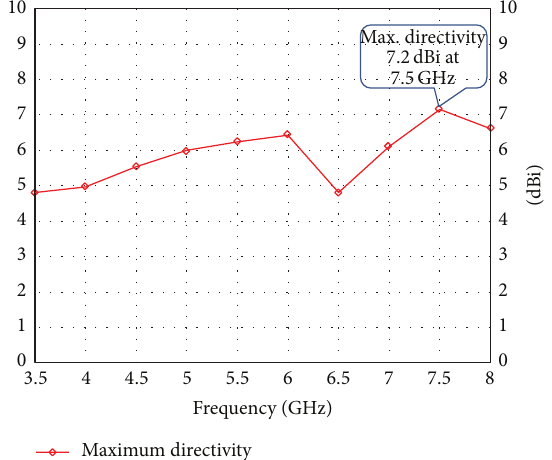
Figure 9: Gain curve for proposed